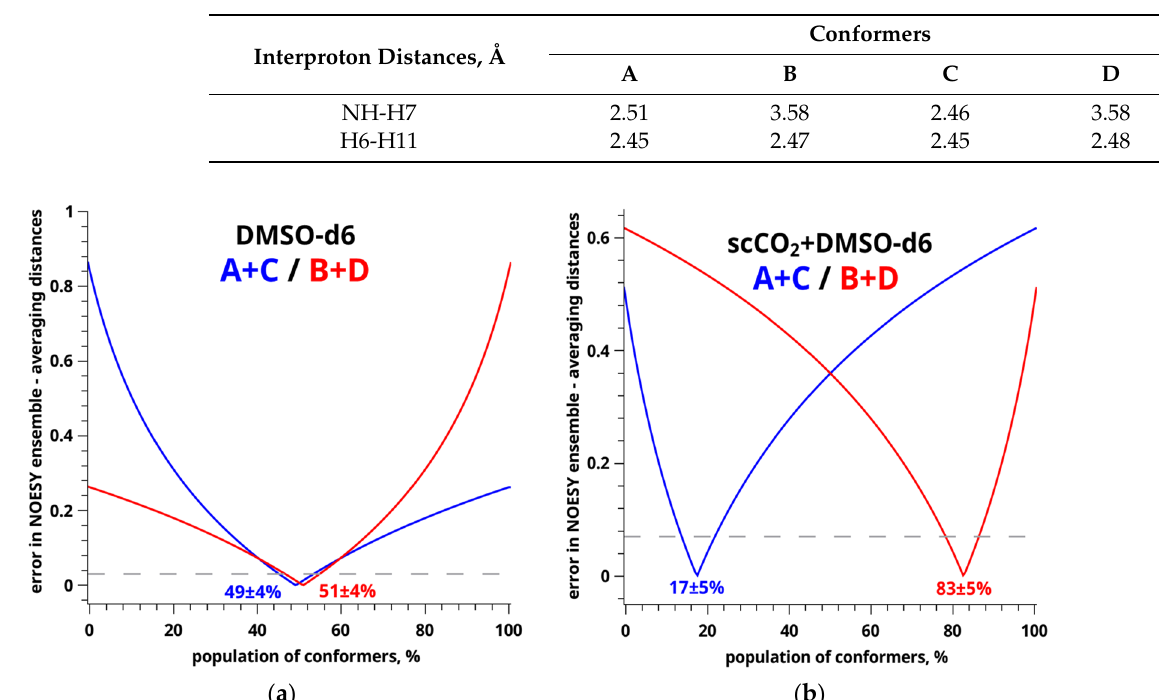
Figure 7. Graphs of the difference between the calculated and experimental distances vs. conformer populations, where fractions of A+C are blue lines; the fractions of B+D are red lines; dashed gray lines are the distance accuracy levels. The experimental data were obtained from the FFA NOESY spectra recorded in DMSO ( a ) and SC-CO 2 + DMSO ( b ).